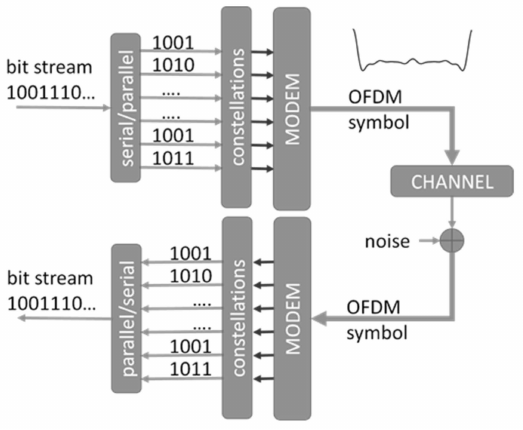
Figure 1. Basic schema of an OFDM transmitter and receiver (T/R)